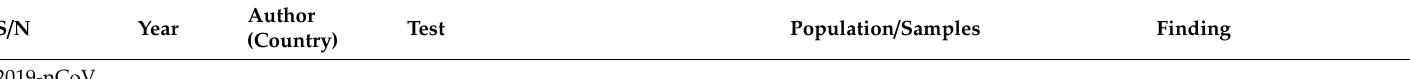
Table 1. Systematic search outcomes for diagnostic evaluation of 2019-nCoV, SARS-CoV and